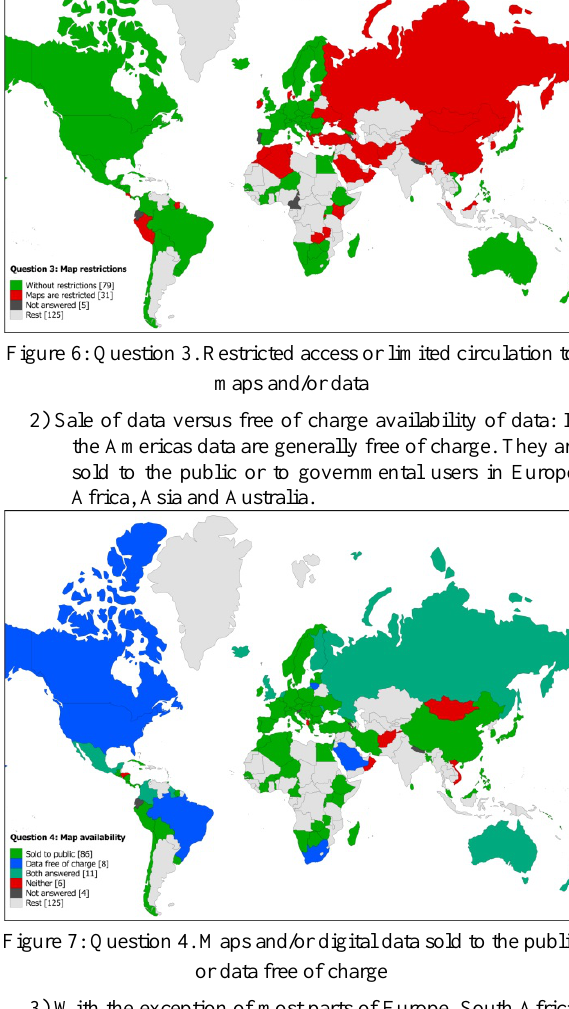
Figure 7: Question 4. Maps and/or digital data sold to the public